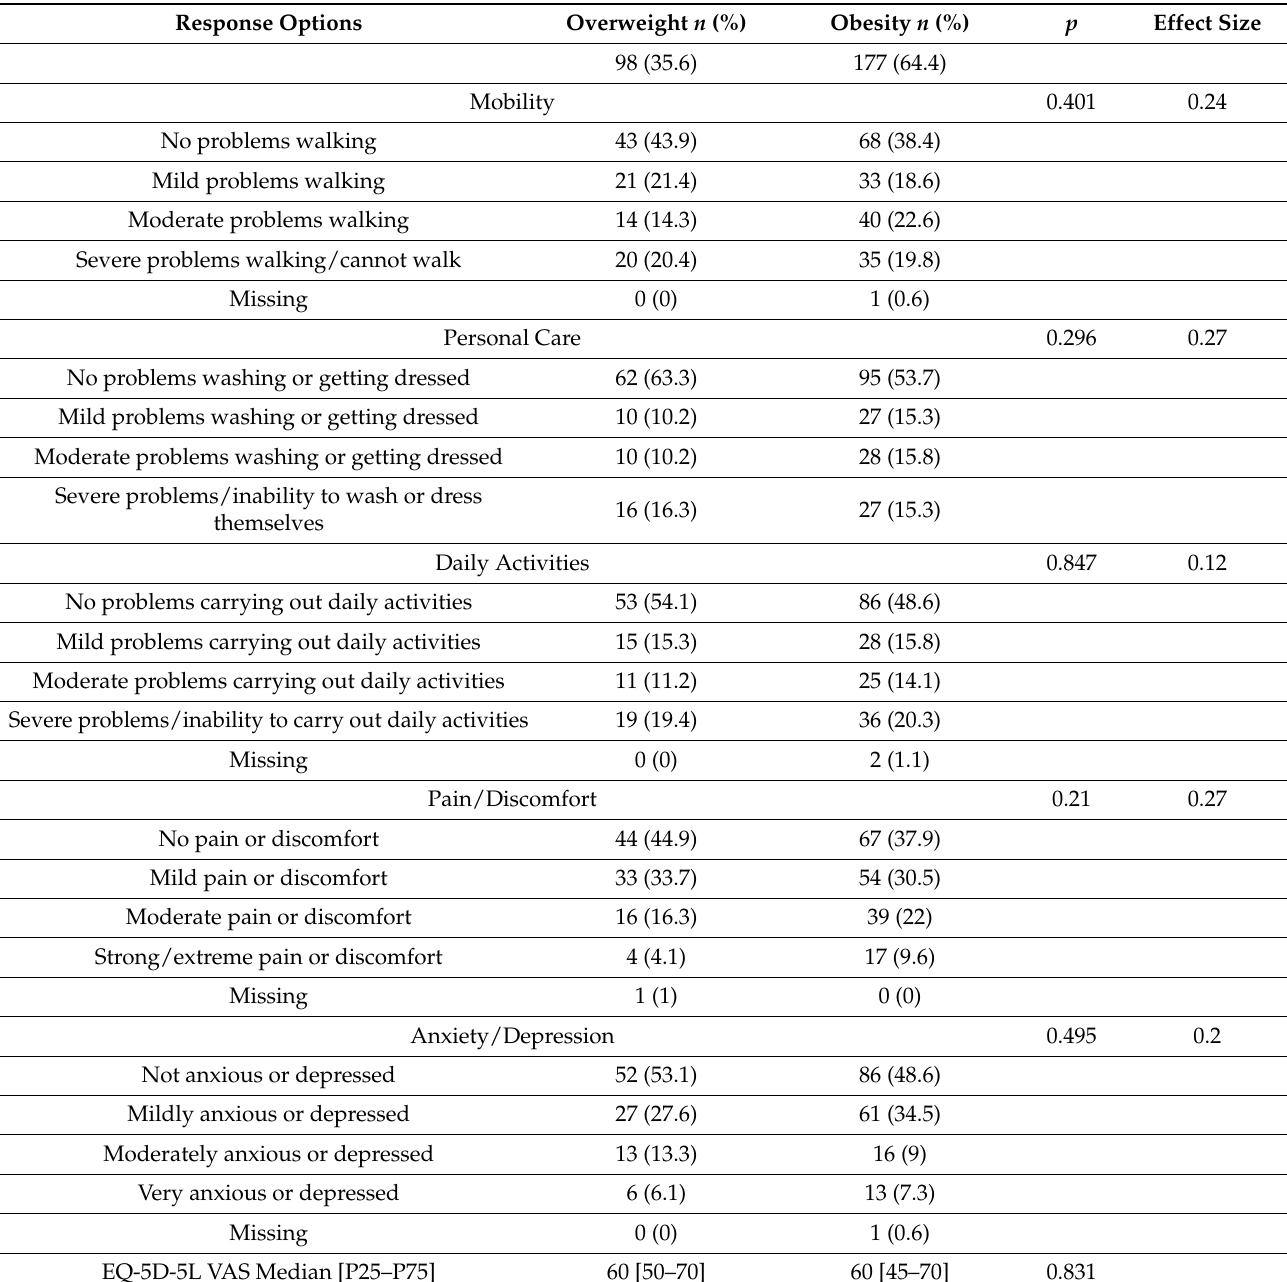
Table 2. EQ-5D-5L L dimensions for self-perceived health between patients with overweight and obesity at discharge. Response